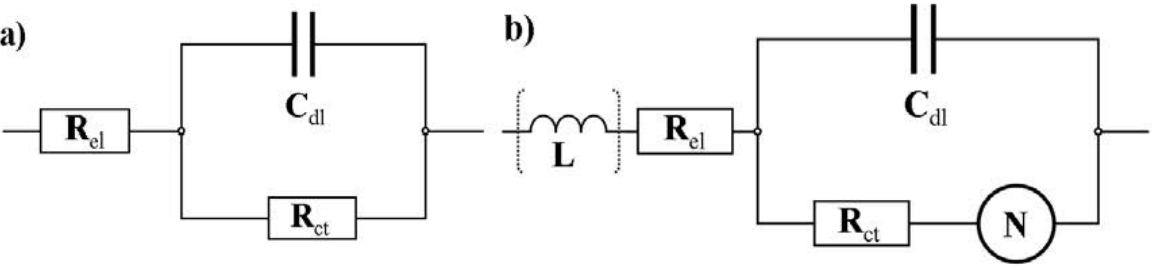
Figure 7. Equivalent circuits used for the simulations of the impedance spectra obtained from the data of Figure 4. ( a ) The RC circuit is used for the simulation of the impedance spectra with low overpotential; ( b ) The equivalent circuit is similar to the Randles circuit but the Warburg impedance is replaced by a finite-length diffusion element (Nernst diffusion element). This circuit is used for the moderate and high overpotential